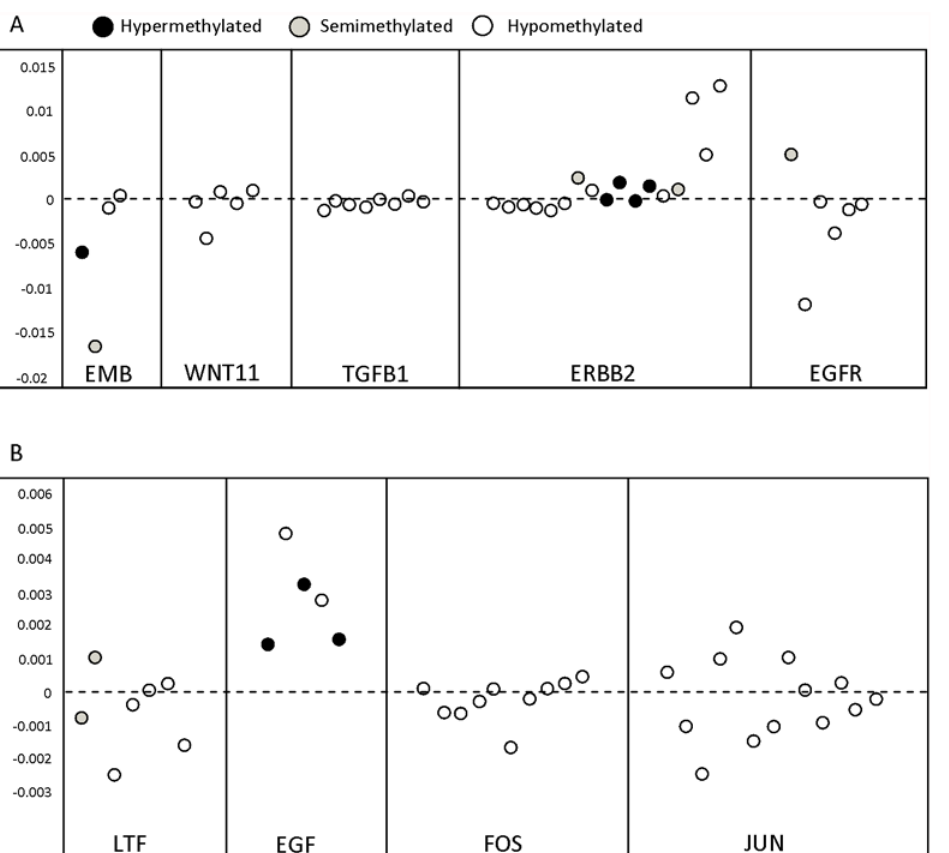
Fig 2. Distribution of CpGs in the 5 ’ end of 9 genes associated with differential methylation in animal models exposed to DES. All CpGs are ordered from 5 ’ to 3 ’ . Y axis shows the difference in mean beta values of exposed and unexposed women. Circle color depicts methylation status of individual CpGs (Black = Hyper-methylated [ (cid:1) 70%], Grey = Semi-methylated [ < 70% > 30%], White = Hypo-methylated [ (cid:3) 30%]). All sites were selected based on annotations from the Illumina manifest. A) Genes that are up regulated in mice exposed to DES. B) Genes that are down regulated in mice exposed to DES.